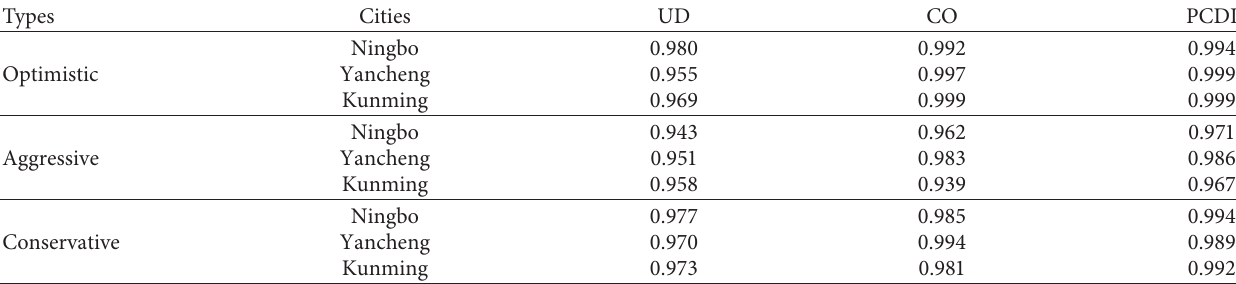
Table 13: Testing the goodness of fit of the time series prediction results.